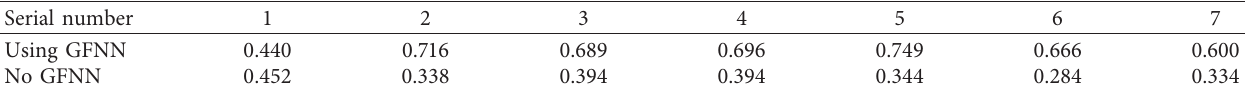
Table 3: System accuracy test results.